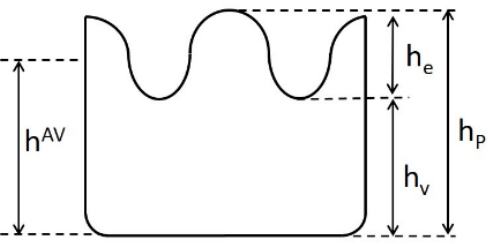
Figure 4. Deep drawn cup parameters for the average earing calculation [6].